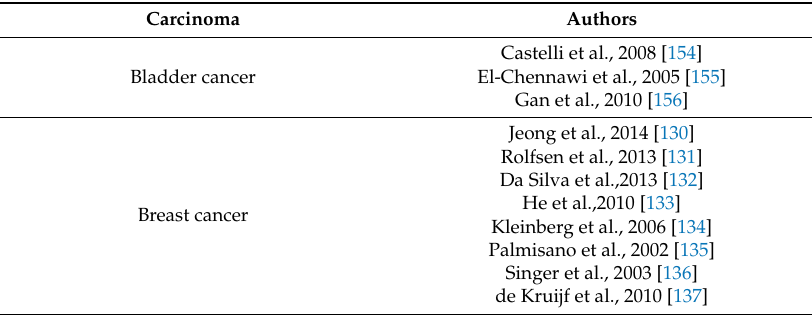
Table 2. Selected literature on expression of HLA-G in malignant